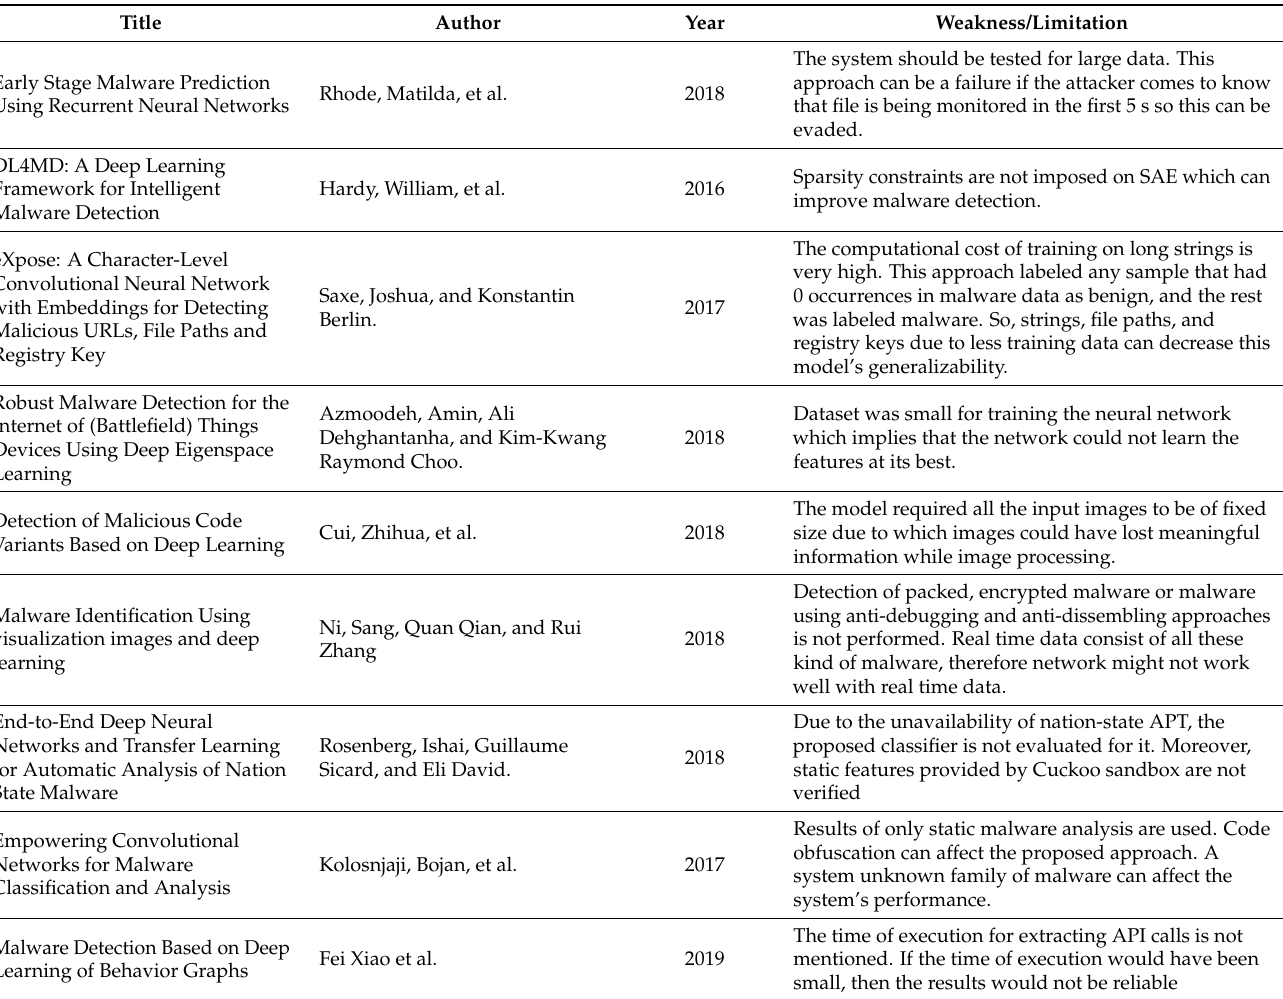
Table 6. Limitations of Surveyed Papers Proposing Deep Learning Based solutions for Malware